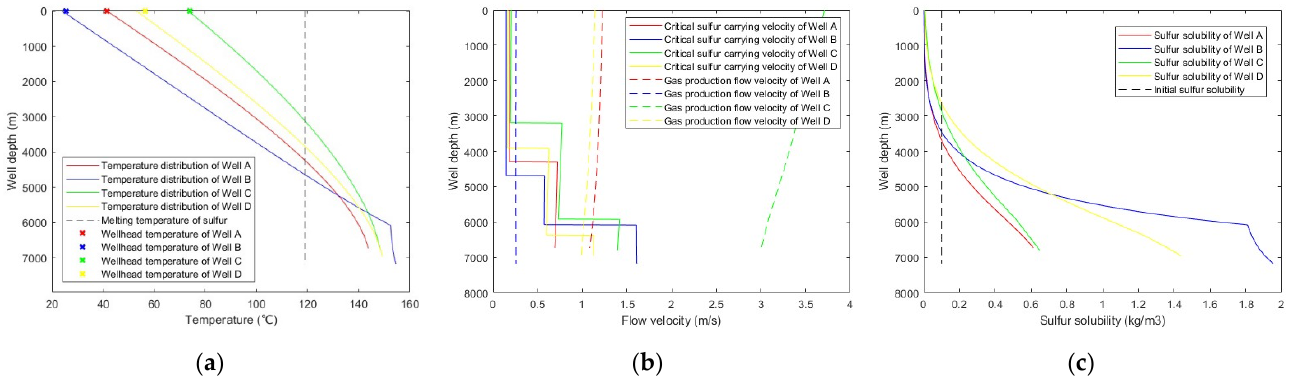
Figure 7. Predicted results with: ( a ) wellbore temperature distribution; ( b ) critical sulfur-carrying velocity versus gas production flow velocity; ( c ) sulfur solubility distribution along the wellbore.